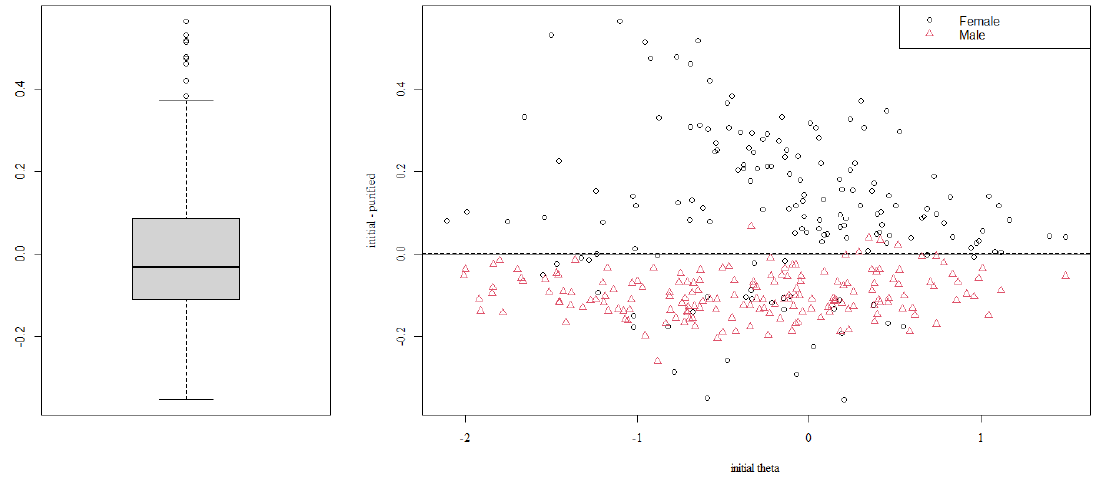
Figure 9. Individual-level DIF impact.